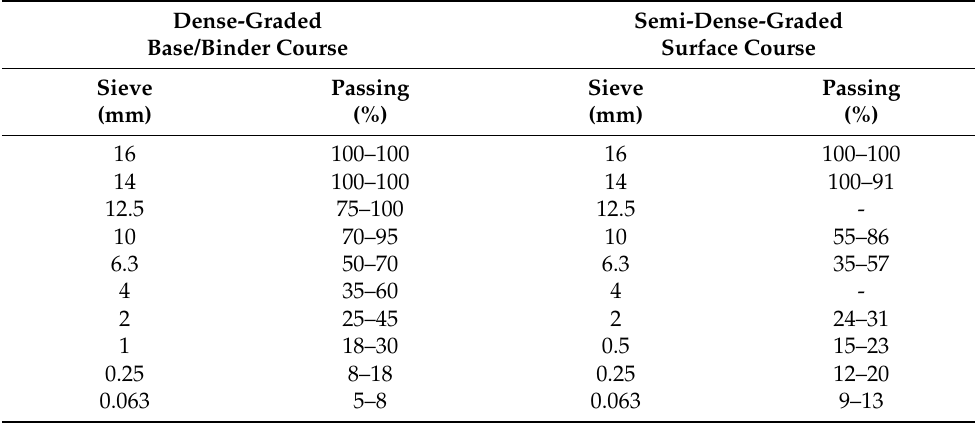
Table 1. Aggregates’ particle distributions of the surface and the base/binder course.